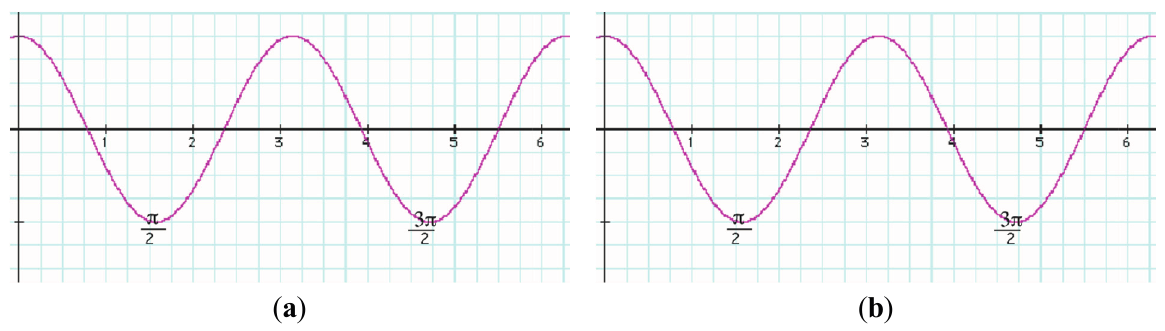
Figure 2. The graph of cos n Θ ( a ) n = 2 and ( b ) n =